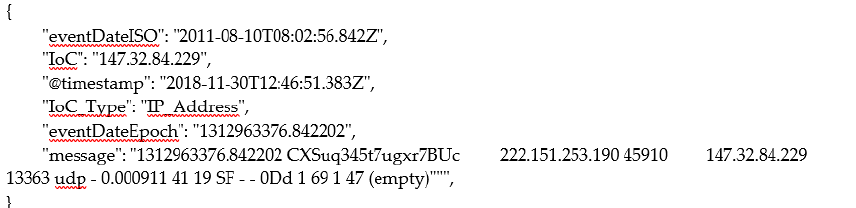
Figure 5. Sample record of the Audit Log Database (ALDB).